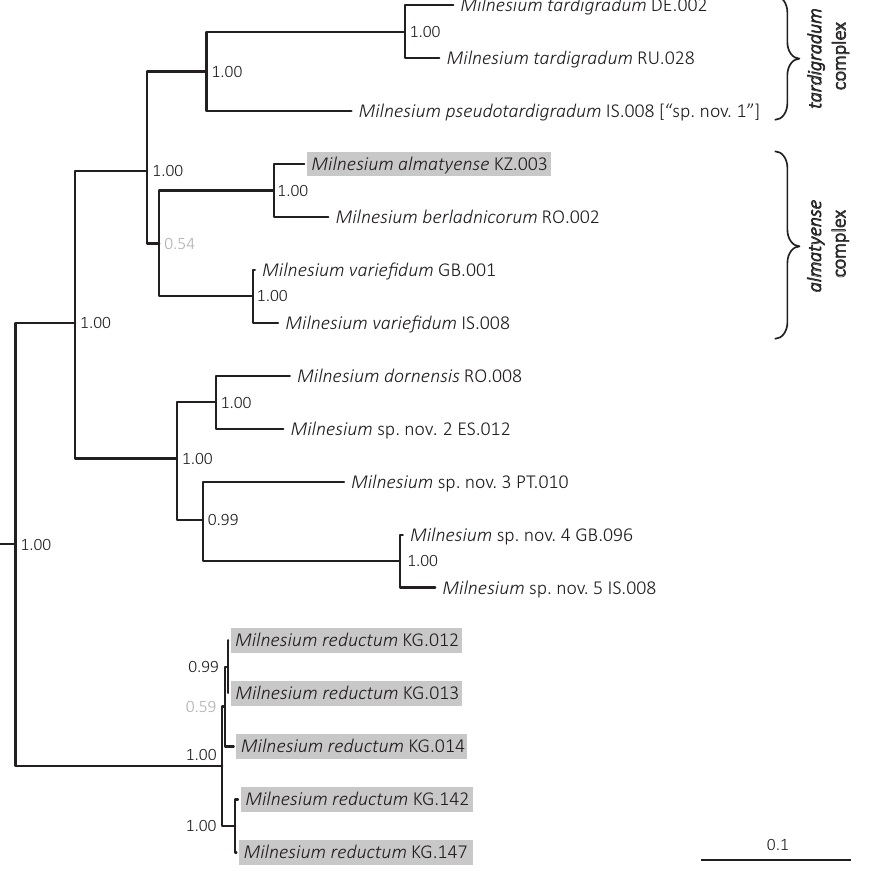
Figure 6. Fragment of the Bayesian phylogenetic tree (“clade A”), based on the analysis of concatenated 18S rRNA + 28S rRNA + ITS-2 + COI nucleotide sequences, obtained by Morek and Michalczyk (2020) with an addition of six new populations, showing the positions of the two Milnesium species analysed in this contribution (shaded in grey): M. almatyense Tumanov, 2006 and M. reductum Tumanov, 2006. The numbers at nodes represent Posterior Probability (PP) supports, with the values in grey font in - dicating poor support (conventionally recognised as polytomy). The scale bar shows the number of substitutions per site. For the remaining parts of the tree, please see Morek and Michalczyk